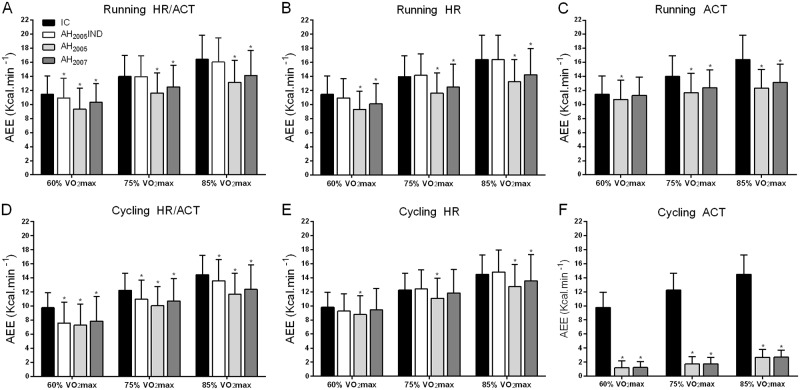
Activity related energy expenditure (AEE) during running and cycling measured by indirect calorimetry (IC) and the different Actiheart models (AH2007, AH2005, AH2005IND) and the activity counts (ACT), heart rate (HR) or combined HR/ACT algorithms.For the HR/ACT and HR algorithms, AEE estimated by the Actiheart increased significantly from 60 to 85% VO2max during running and cycling (P <0.01). For the ACT algorithm, AEE also increased with intensity increments during running (P <0.01), but only very slightly and not proportionally to intensity during cycling. *P <0.05 between AEE measured by the Actiheart and indirect calorimetry.